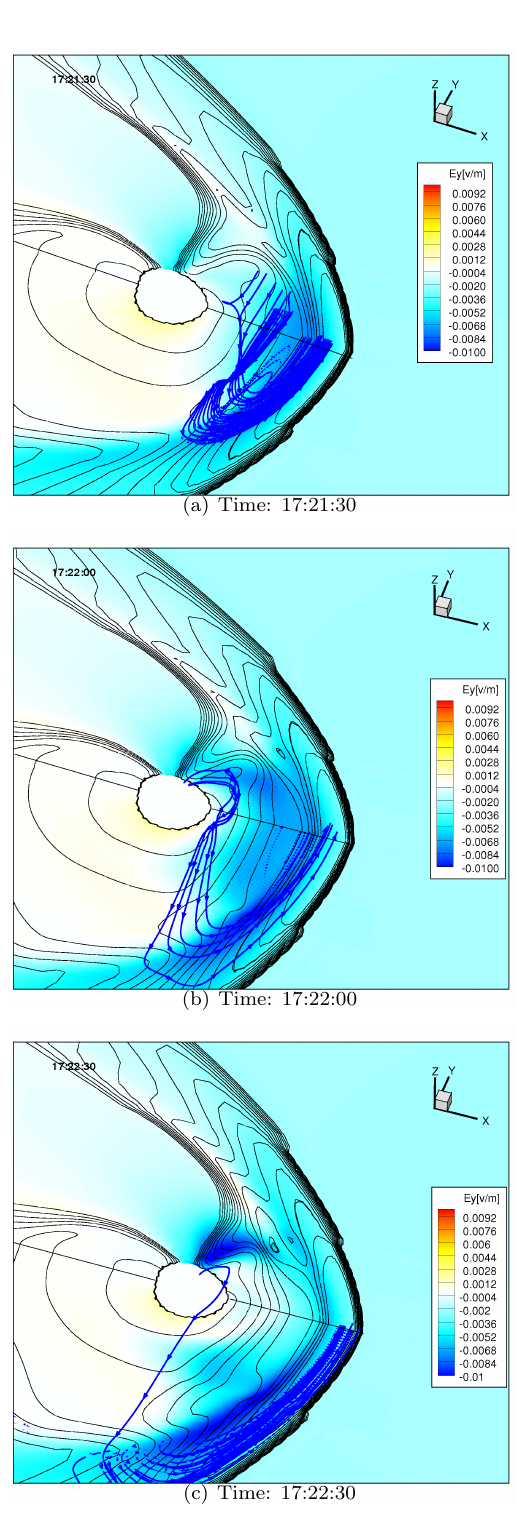
Fig. 6. The current flow in a 3-D view in the first phase. Blue lines: current flow; Color on the Z=0 and Y=0 plane: electric field in Y di- rection; black contour lines: thermal pressure in the magnetosphere. The axis orientation is shown in the upper right